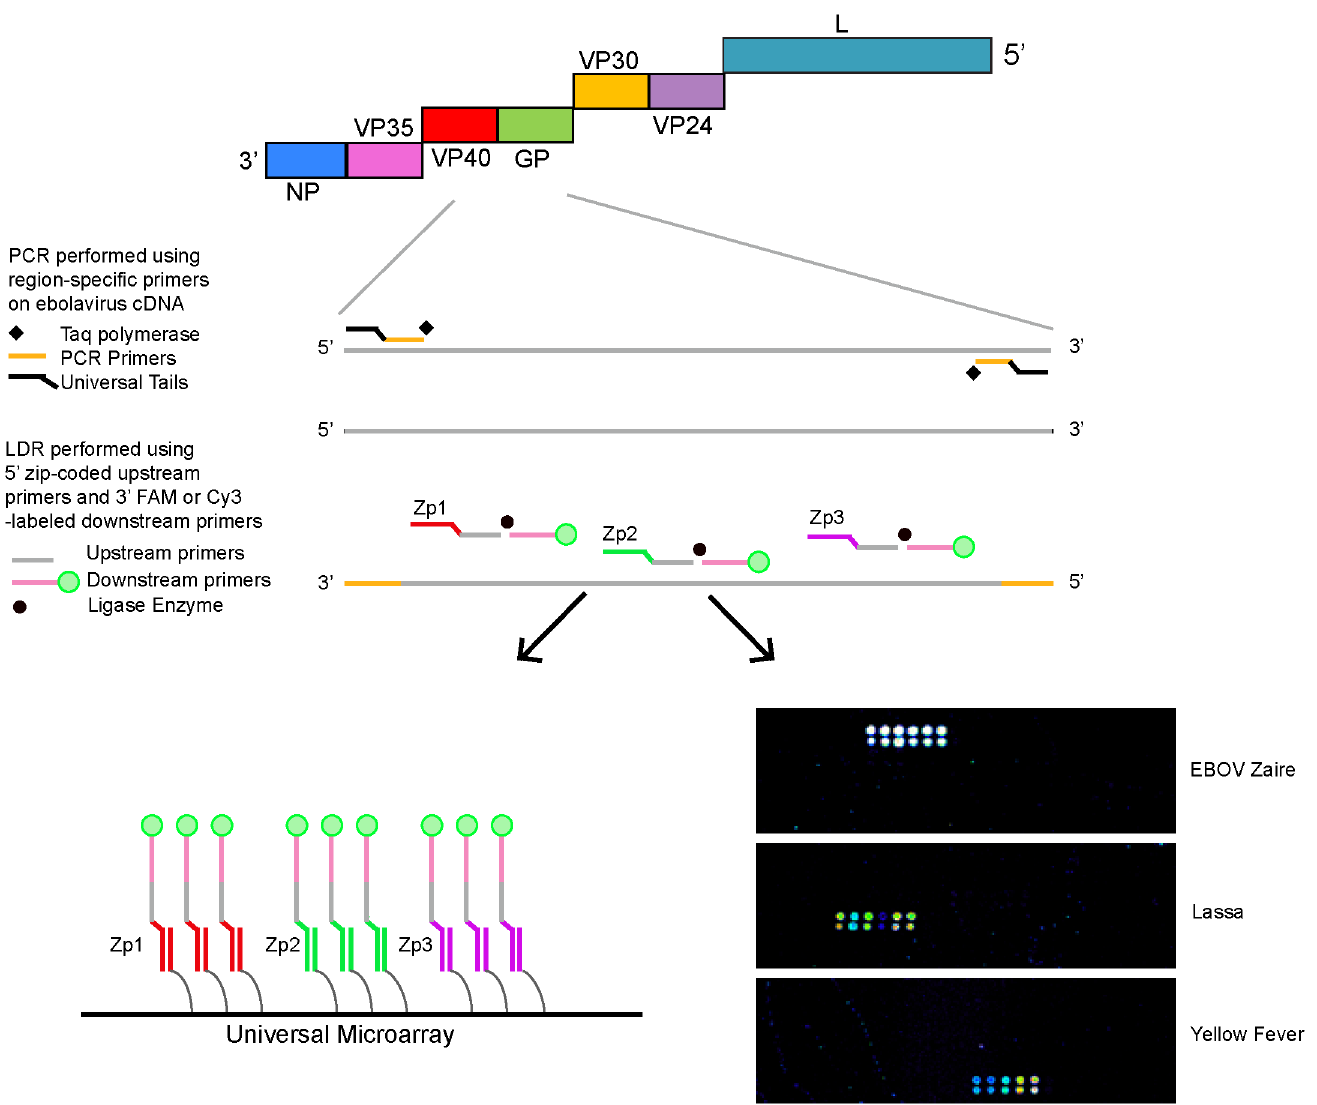
Fig 1. Schematic of the PCR/LDR assay for detection of VHF viruses. For each virus (ebolavirus is shown as a representative virus), 1 – 2 different regions are amplified by RT-PCR using forward and reverse primers, each with minimal degeneracy and all containing universal tails to prevent the formation of primer dimers. Cy-3 labeled downstream LDR primers and single base-discriminating upstream primers with unique zip-code complements (20-30-mers) are targeted to specific sequences/SNPs within the PCR amplicons. Ligation of two adjacent oligonucleotides annealed to a complementary DNA target occurs in the presence of thermostable ligase only if the nucleotides are perfectly matched at the junction [54, 55]. The zip-code complements on the 5 ’ end of fluorescently labeled LDR products anneal to specific complementary zip-code addresses on a universal array [56, 57]. A positive signal on the universal array is detected as a fluorescent spot. Primers for the ligation reaction were designed targeting 2 or 3 areas within each PCR amplicon. Each virus could produce a maximum of six ligation products, except for VAR and VACC, for which there were a maximum of 5 each. The detection of 2 or more ligation products was required for the detection and identification of a virus. Representative arrays that detect and identify Ebola Zaire , Lassa and Yellow fever viruses are